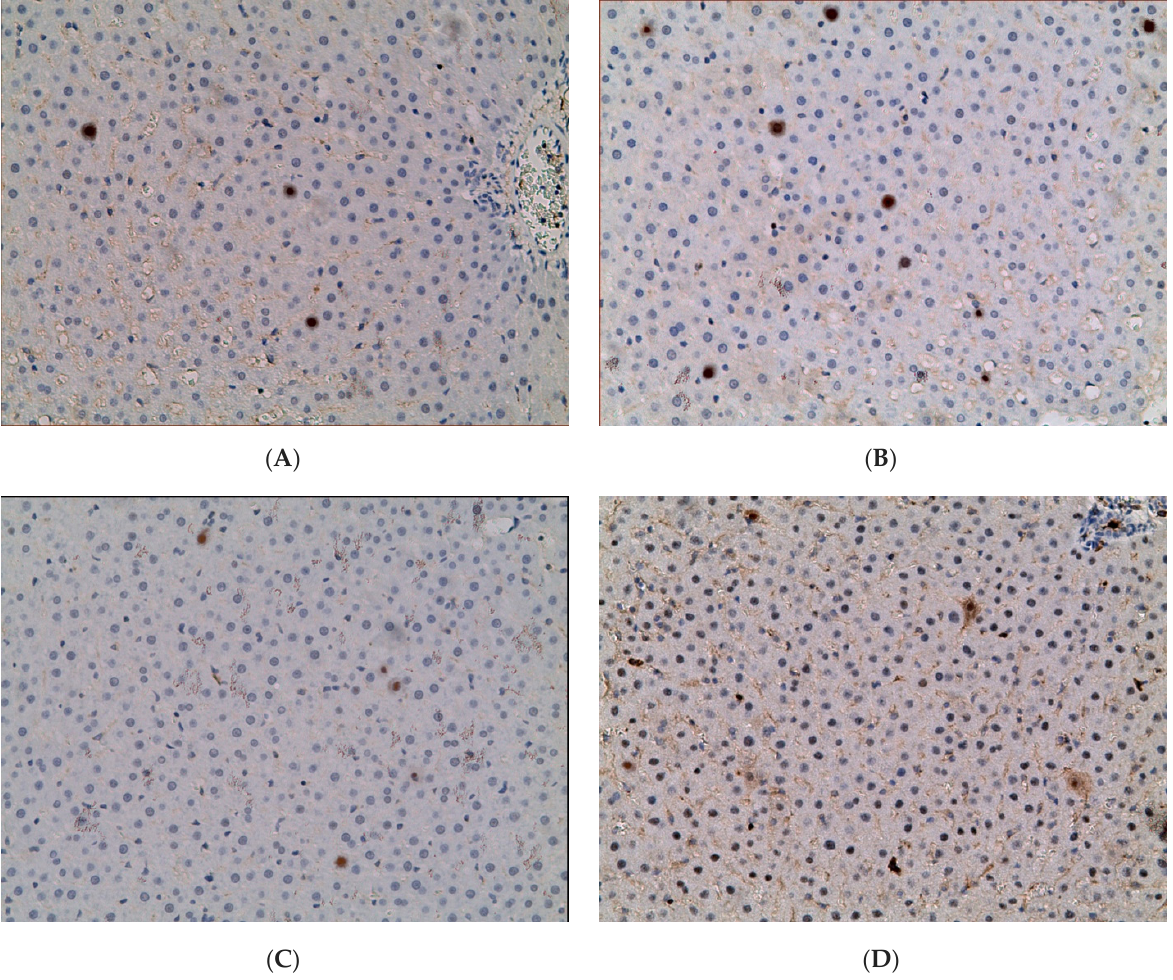
± 8.88%), in CL group—4.32 times lower (16.67 ± 6.84%), and 2.58 times lower (27.90 ±